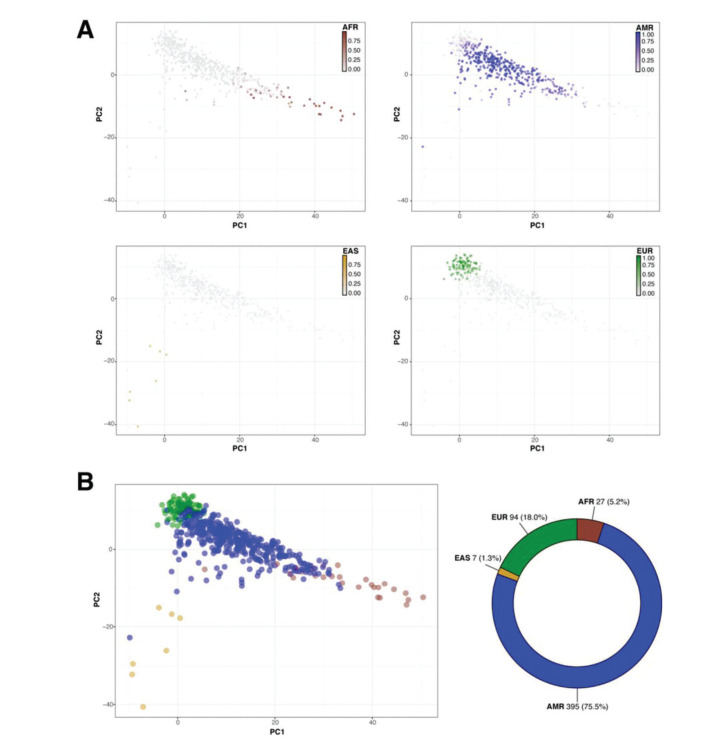
Classification of SELAdb individuals using a neural network classifier and 1000 Genomes populations as the training set. Panel A depicts a series of biplots (x-axis: PC1, y-axis: PC2) representing the PCA analysis of SELAdb individuals, which are color-coded according to the posterior probabilities of being classified as a distinct population by using 1000 Genomes, including AFR (brown, upper left), AMR (blue, upper right), EAS (yellow, lower left), and EUR (green, lower right). Panel B depicts a biplot (left; x-axis: PC1, y-axis: PC2) representing each SELAdb individual, which is color-coded according the final classification given by the neural network classifier. The final distribution of individuals in each category are represented in the donut plot (right). Consistent with the distribution of SELAdb individuals in Panel A, most SELAdb individuals are classified as AMR.